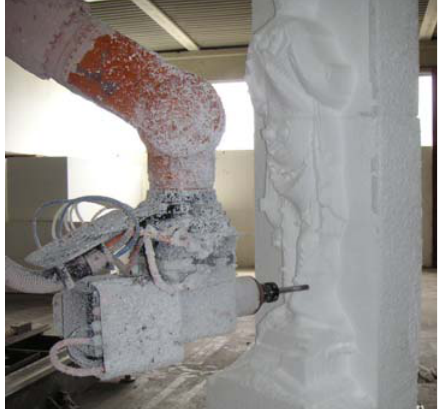
Figure 5. A CNC robotic milling machine working on the replica of the stature in Figure